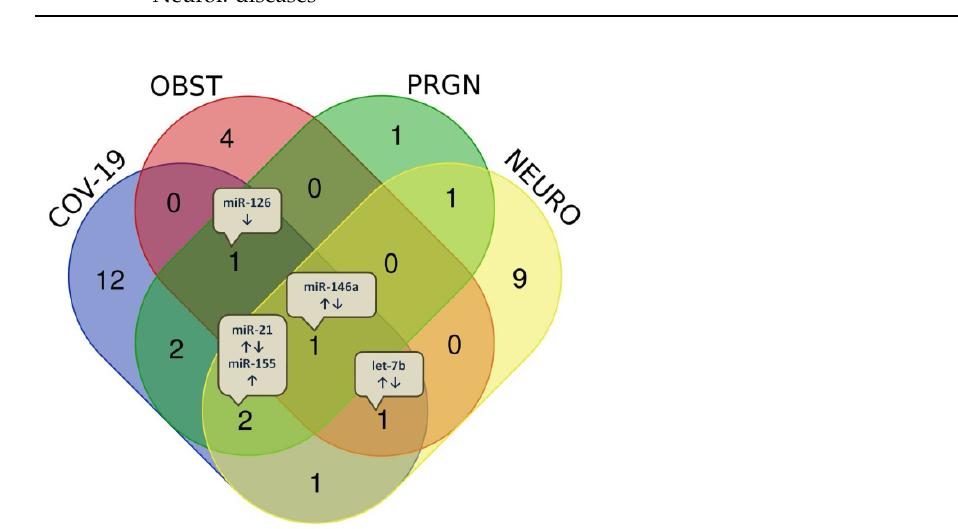
Figure 2. Numbers of overlapping of representative miRNAs in several different physiologically altered conditions, associated with COVID-19. The alternatively expressed miRNAs are presented in text bubbles. COV-19—covid-19; OBST—obesity; PRGN—pregnancy; NEURO—neurological diseases.